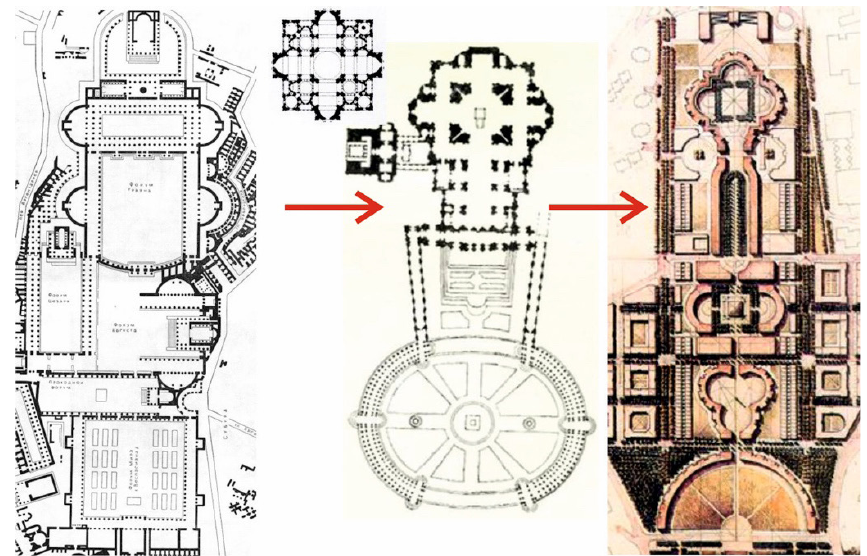
Figure 9. The method of historical association. Comparison of the layout of ancient Roman forums, the ensemble of the cathedral and St. Peter’s Square in Rome and the ensemble of Antigone in Montpellier by R. Bofill (1978−2000) (source: author